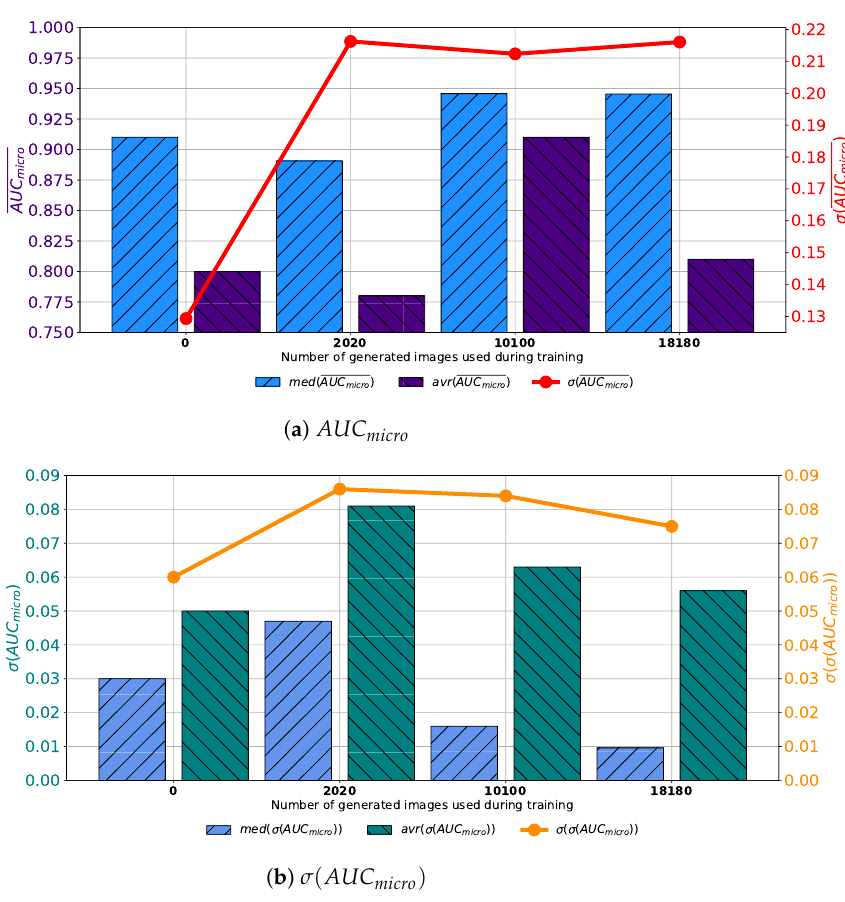
Figure 11. Median, average AUC micro and standard deviation of AUC micro and σ ( AUC micro ) for the case of VGG-16 trained with images generated by GAN in 100